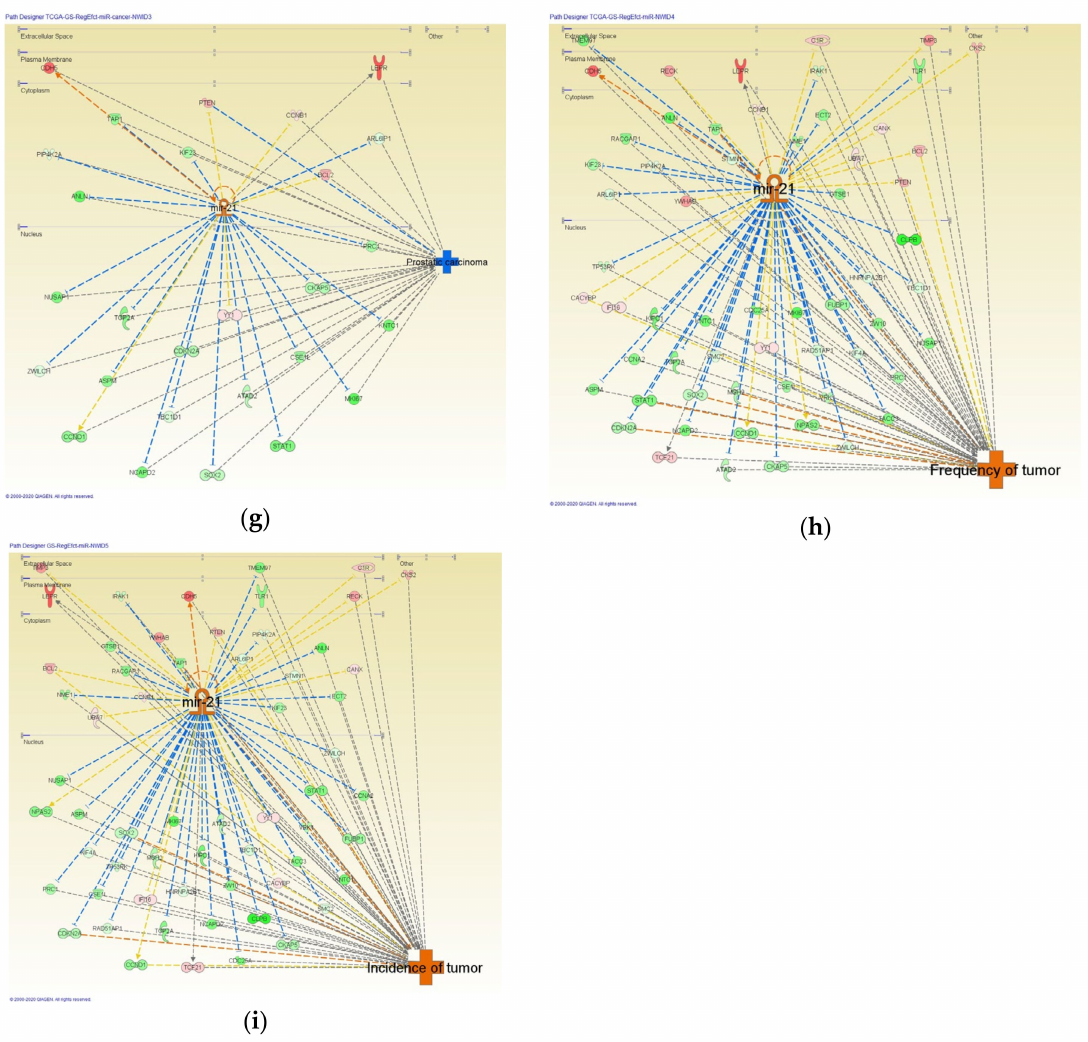
Figure 4. MicroRNA (miRNA)-regulated networks in intestinal- and di ff use-type gastric cancer (GC). The molecular regulators for which types were set as “miRNA” and “mature miRNA” were analyzed in the data set of intestinal-type ( a – d ) or di ff use-type ( e – i ) GC. Four networks were generated in intestinal-type GC, while five networks were generated in di ff use-type GC. ( a ) Network ID#1 regulated by miR-205-5p (and other miRNAs w / seed CCUUCAU), miR-21-5p (and other miRNAs w / seed AGCUUAU), and mir-290 in intestinal-type GC; ( b ) Network ID#2 regulated by let-7a-5p (and other miRNAsw / seedGAGGUAG)inintestinal-typeGC;( c )NetworkID#3regulatedbylet-7inintestinal-type GC; ( d ) Network ID#4 regulated by mir-21 in intestinal-type GC; ( e ) Network ID#1 regulated by let-7, miR-24-3p (and other miRNAs w / seed GGCUCAG) in di ff use-type GC; ( f ) Network ID#2 regulated by mir-181, miR-291a-3p (and other miRNAs w / seed AAGUGCU), miR-34a-5p (and other miRNAs w / seed GGCAGUG) in di ff use-type GC; ( g ) Network ID#3 regulated by mir-21 in di ff use-type GC; ( h ) Network ID#4 regulated by mir-21 in di ff use-type GC; and ( i ) Network ID#5 regulated by mir-21 in di ff use-type